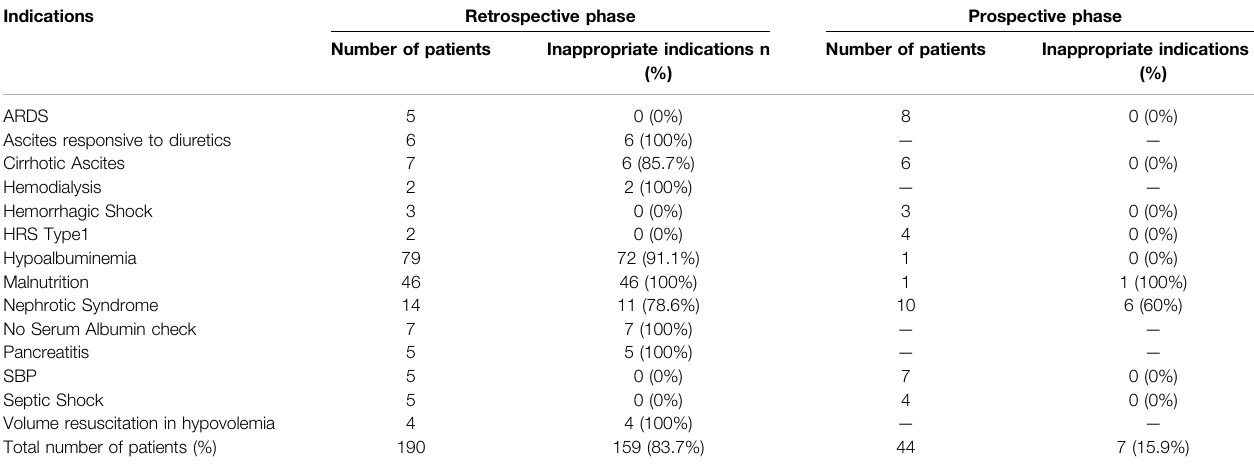
Total number of patients (%)